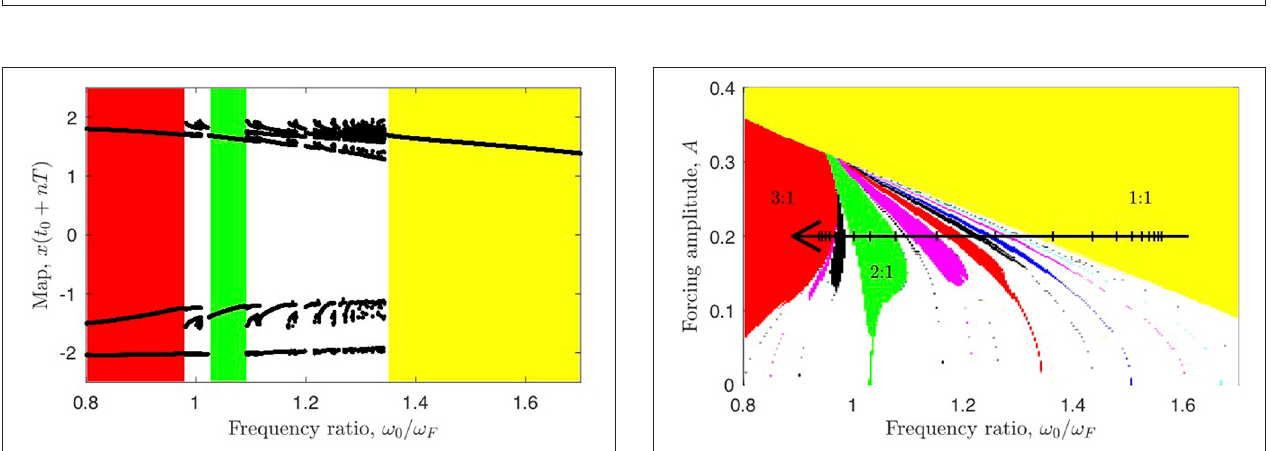
FIGURE 5 | The van der Pol oscillator (5): The left panel shows the phase plane. The black curves are the nullclines. A trajectory is shown in blue. The dots marking the trajectory at equal time intervals indicate two slow branches near the x-nullcline. The right panel shows that this is a slow/fast dynamical system with the fast variable x ( t ) (in blue) closely following the x -nullclines (critical/slow manifold) interrupted by fast jumps from one branch to the other. The slow variable y does not change at the jumps. Parameters are ( α , γ )=(1, 5).